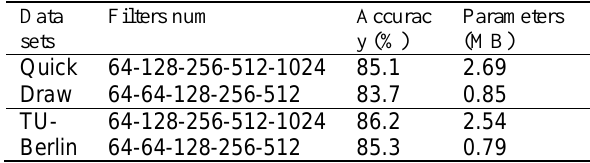
Table 4. Effect of fewer convolutional filters per